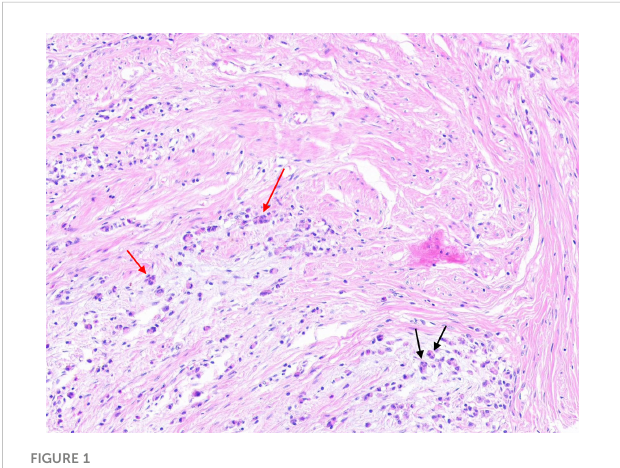
FIGURE 1 The black arrow represents tumor budding in gastric cancer (single tumor cells or clusters of up to four tumor cells), and the red arrow represents poorly differentiated cluster (PDC) in gastric cancer ( fi ve or more